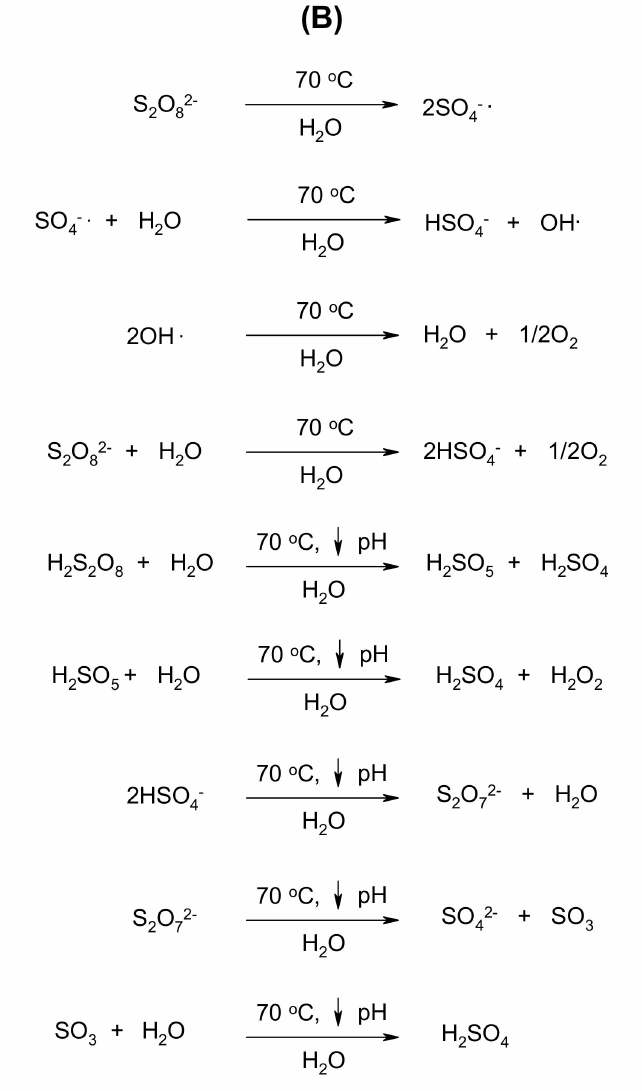
Figure 1. The basic steps of the synthesis of poly-2-acrylamido-2-methyl-1-propanesulfonic acid (PAMPSA) by polymeriza- tion of 2-acrylamido-2-methyl-1-propanesulfonic acid (AMPSA) aqueous solution in the presence of potassium persulfate (KPS) initiator ( A ) and potential reactions of radicals and ions produced by potassium persulfate decomposition in water ( B